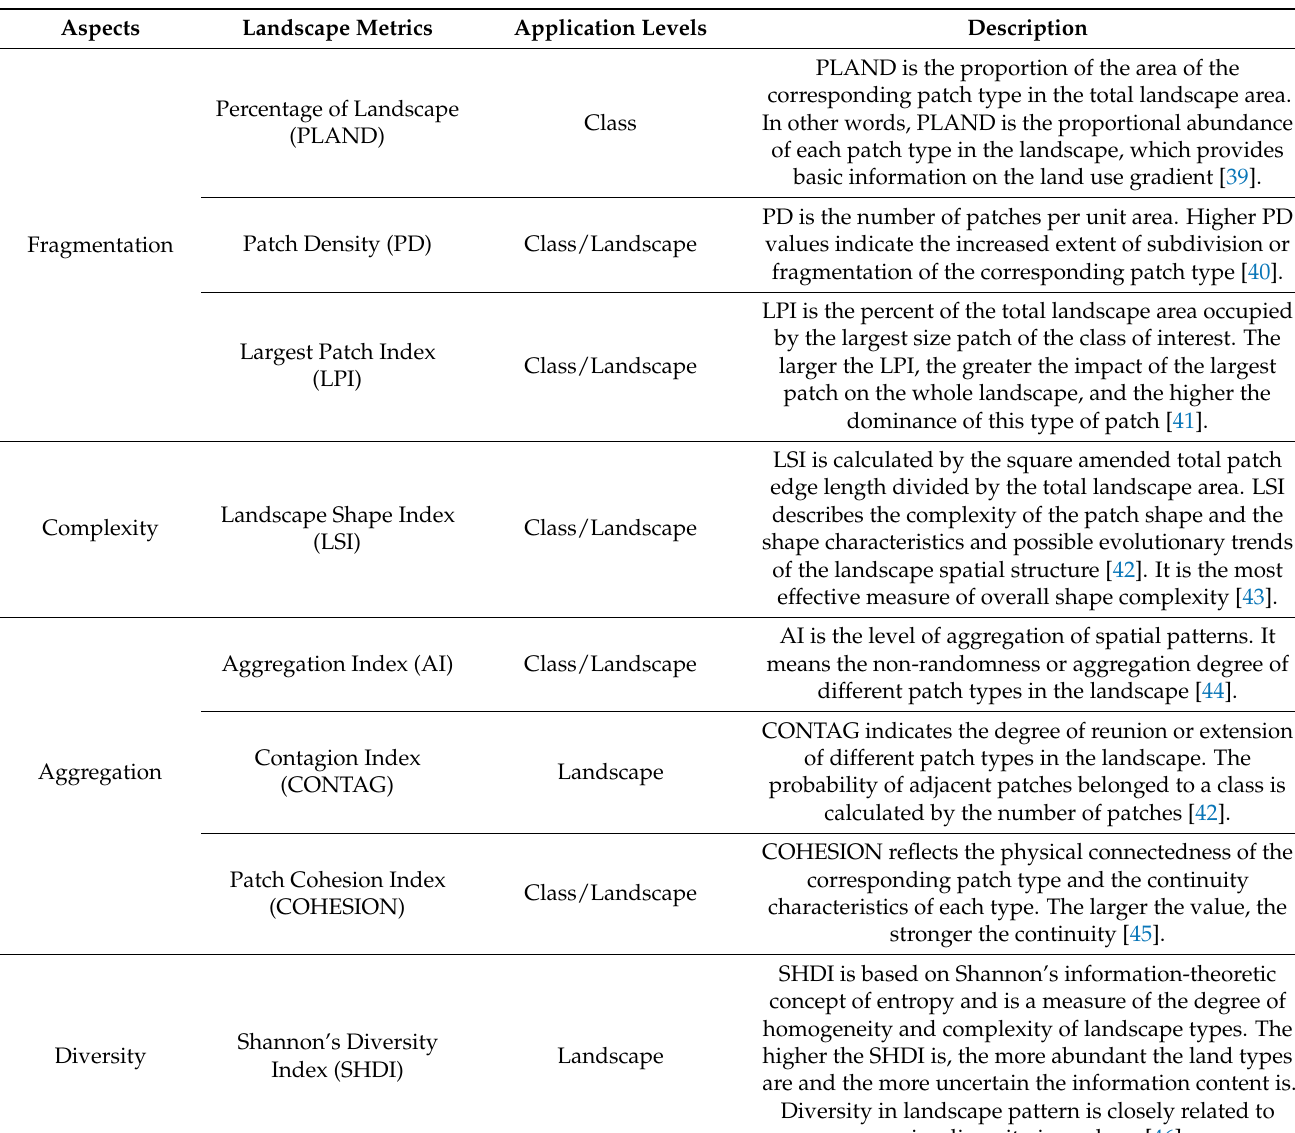
Table 2. Metrics proposed to describe the urban landscape